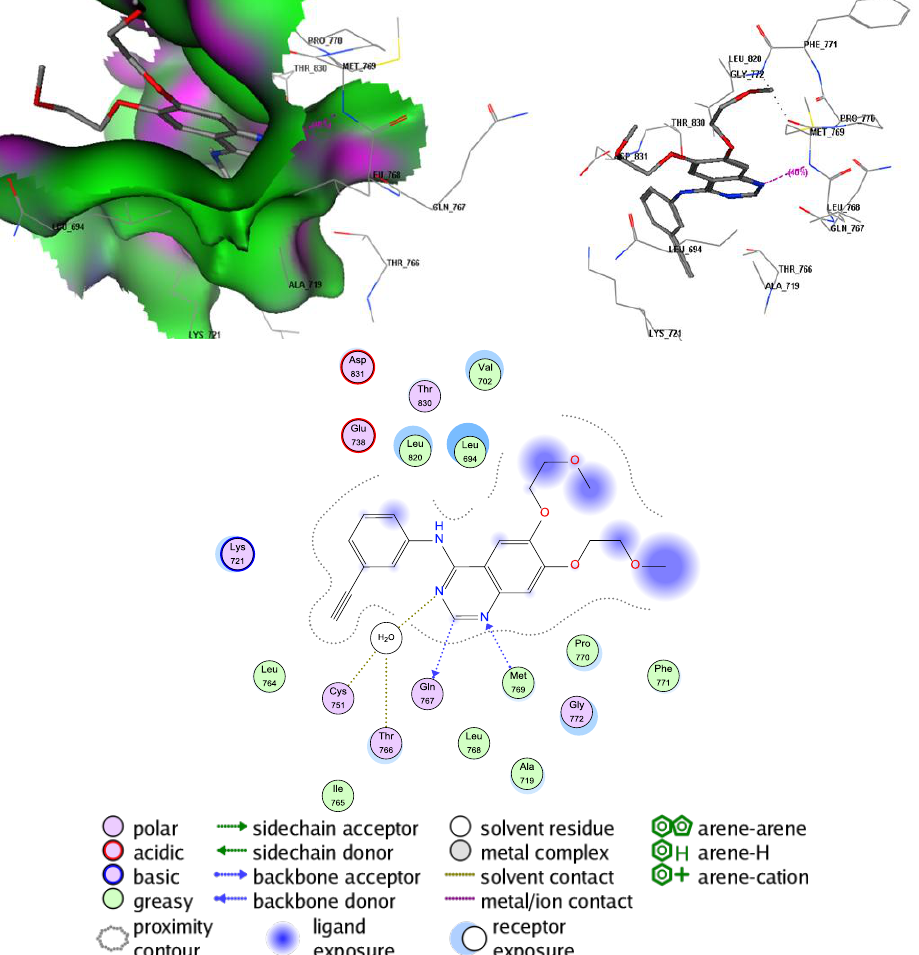
Figure 5. 3D and 2D interactions of erlotinib with EGFR binding site show one type of hydrogen